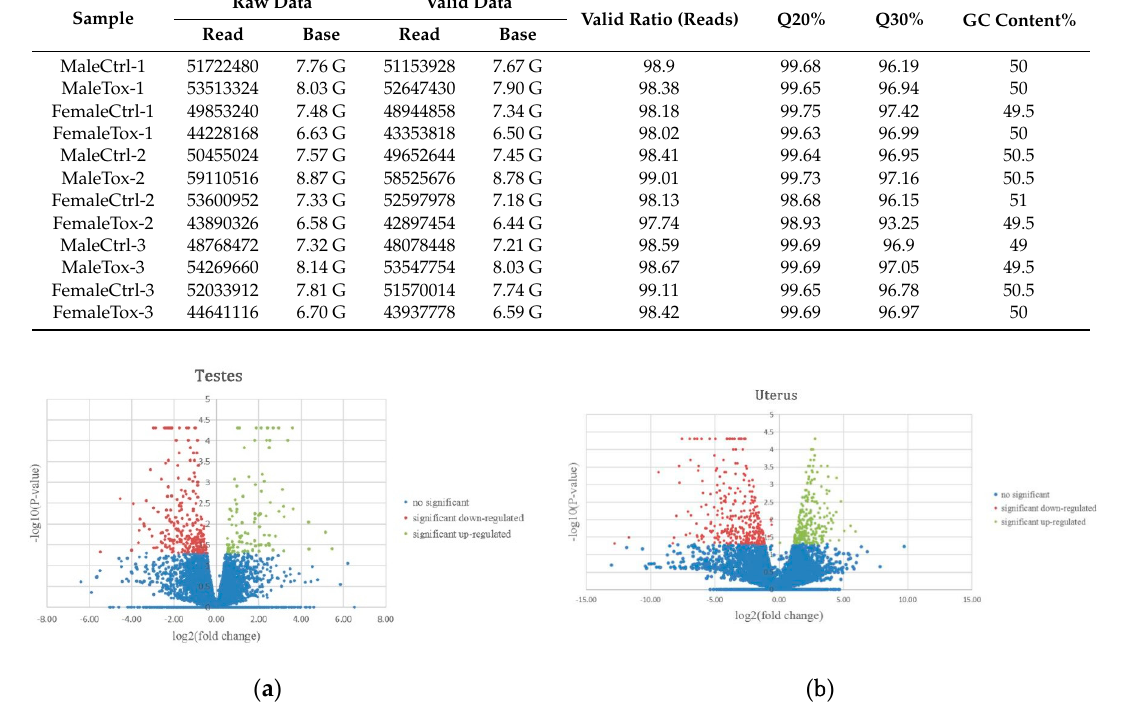
Figure 3. Volcano maps of differentially expressed genes in testes ( a ) and uterus ( b ) compared to control group. Significantly upregulated and downregulated genes are shown as red and green dots, respectively. Blue dots indicate genes that are not significantly different in expression.